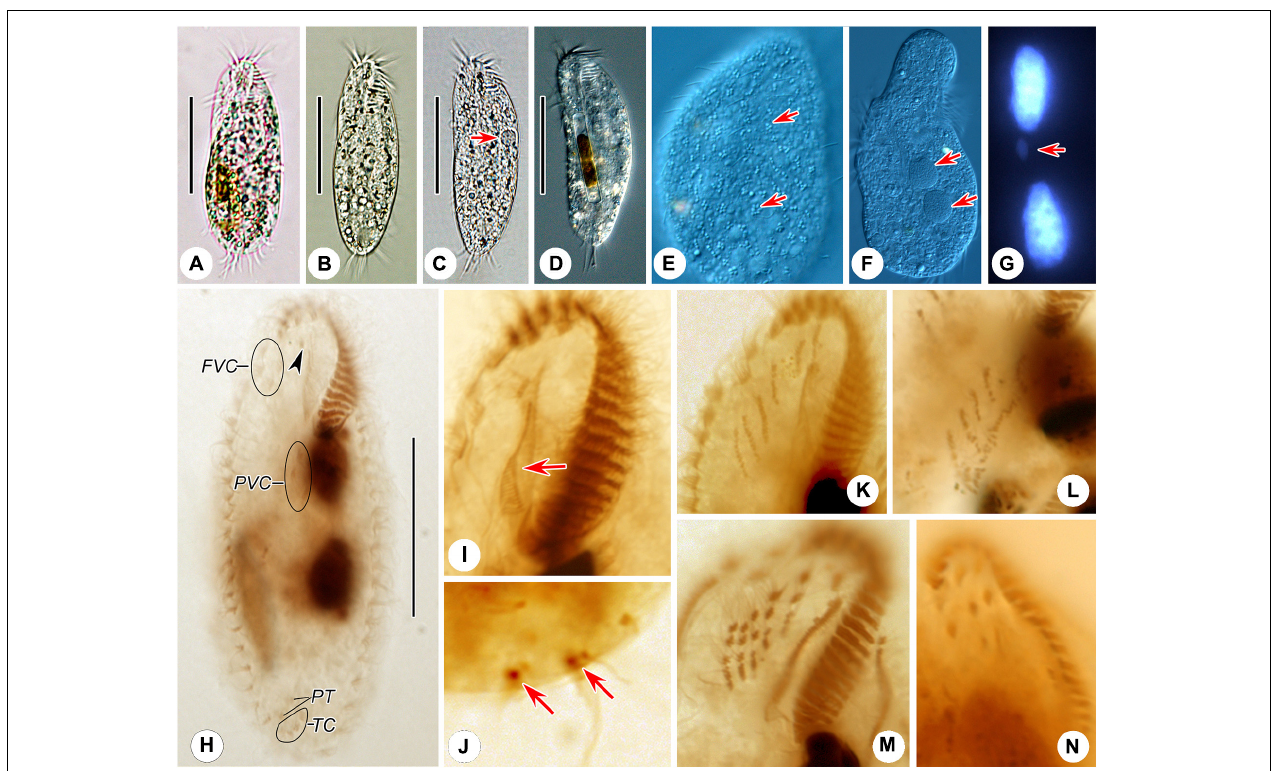
FIGURE 2 | Photomicrographs of Hemiurosomoida tibetensis sp. nov. in vivo (A–F) , after DAPI staining (G) and protargol (H–N) staining. (A–D) Ventral view of different cells, showing variation in body shapes and contractile vacuole (arrow). (E) Dorsal view, showing the arrangement of cortical granules (arrows). (F) Two spherical macronuclear nodules (arrows). (G) Two macronuclear nodules and one ellipsoid micronucleus (arrow). (H) Ventral infraciliature and nuclear apparatus of the holotype, arrowhead indicates buccal cirrus. (I) Ventral view of infraciliature of the anterior portion of a specimen, arrow shows paroral membrane. (J) Two caudal cirri (arrows). (K,L) Ventral views, show the newly formed frontal-ventral-transverse cirral anlagen in both proter (K) and opisthe (L) . (M,N) Ventral views, showing the newly formed cirri in the proter. FVC, frontoventral cirri; PT, pretransverse ventral cirri; PVC postoral ventral cirri; TC, transverse cirri. Bars, 40 µ